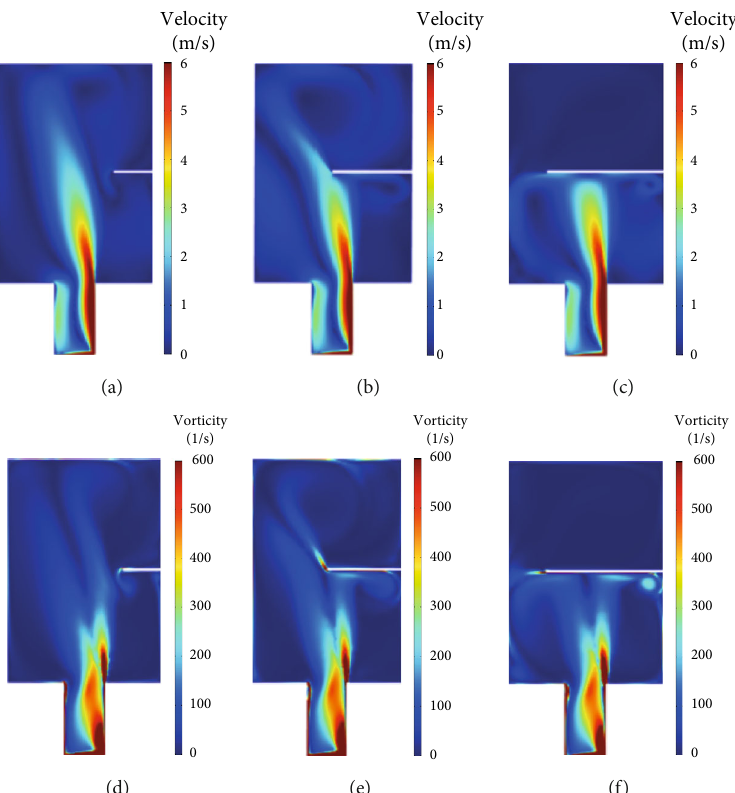
Figure 7: Comparison of the velocity and vorticity contours, as M 0.25 to 0.5 and 0.75. (a, d) L